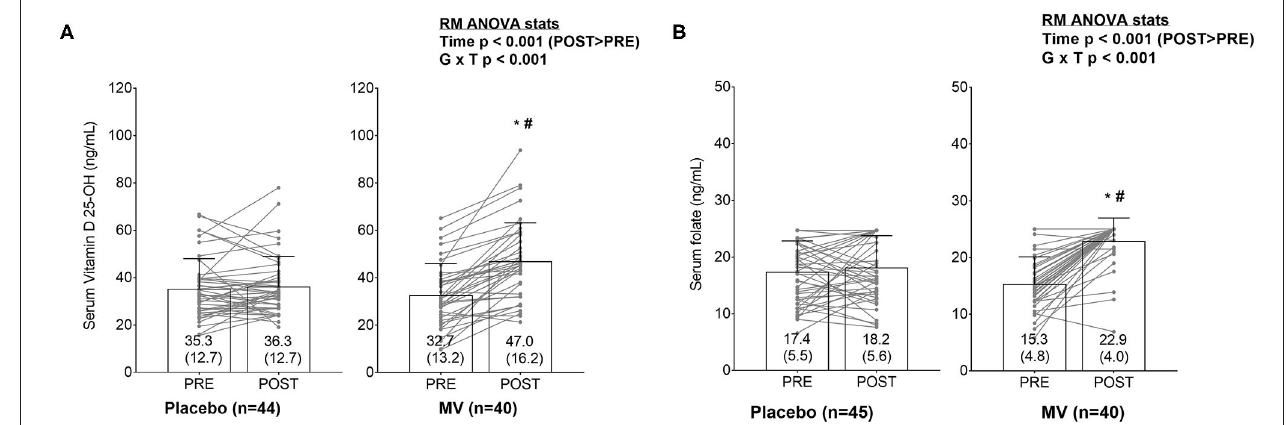
FIGURE 2 | (A,B) Changes in serum vitamin D and folate levels between groups. Bar graphs are plotted as means ± standard deviation values (which are also indicated numerically at the bottom of each bar), and gray data points indicate individual respondents. The significant group × time (G × T) interactions for each variable prompted LSD post-hoc tests within each group and between groups at each time point. Both serum markers increased from PRE to POST in MV group (* p < 0.05). Additionally, POST values for both serum markers were elevated in the MV vs. placebo group (# p < 0.05).